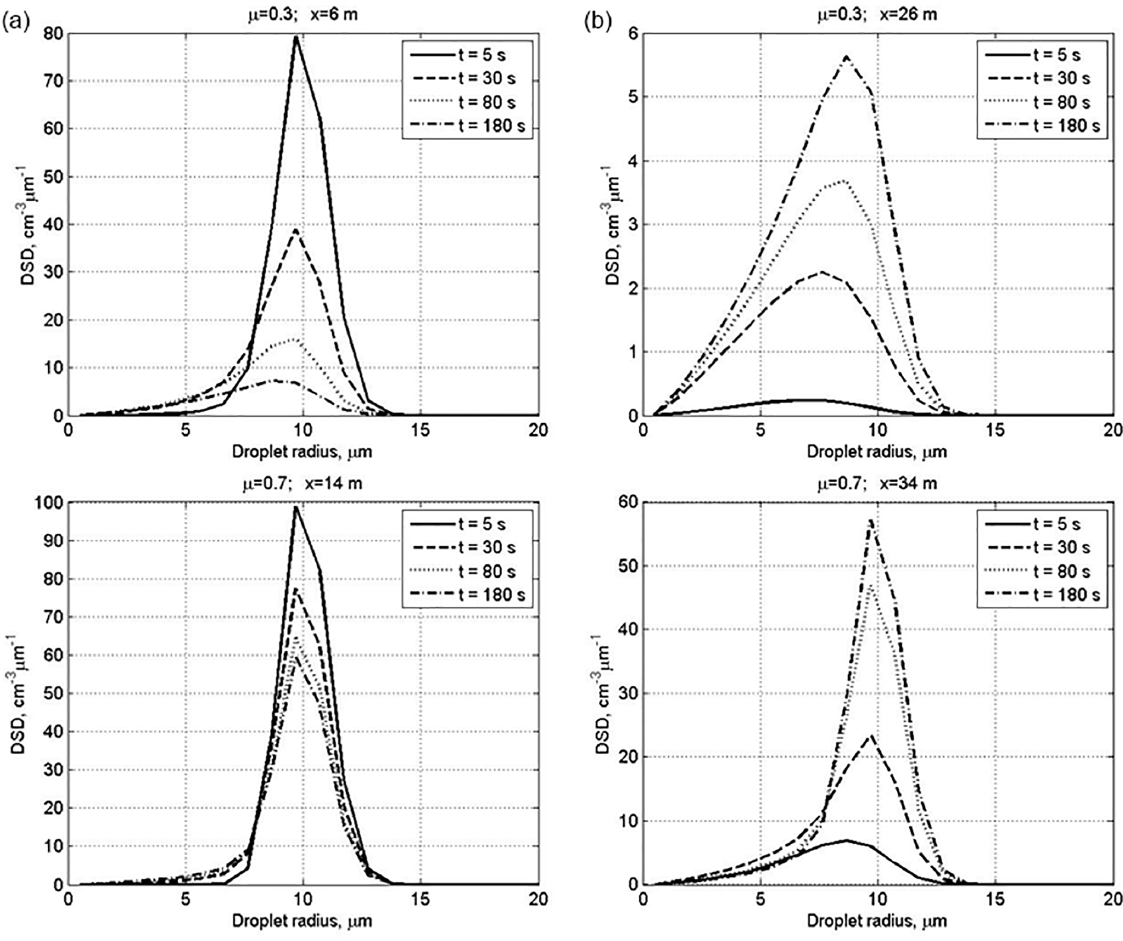
Figure 3. Time evolution of DSD in the centers of the initially cloudy volume (a) and of the initially dry air volume (b) at initially narrow DSD. The initial mixing parameters are RH 2 = 80%, T = 10 ◦ C, p = 828.8mb and L =